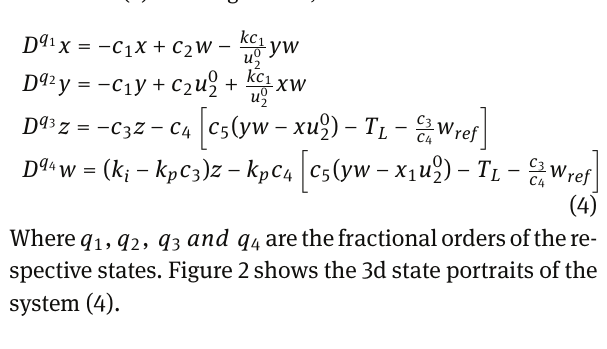
181.1 and initial conditions are x 1 = 0; x 2 = 0.4; x 3 = −200; x 4 = 6.